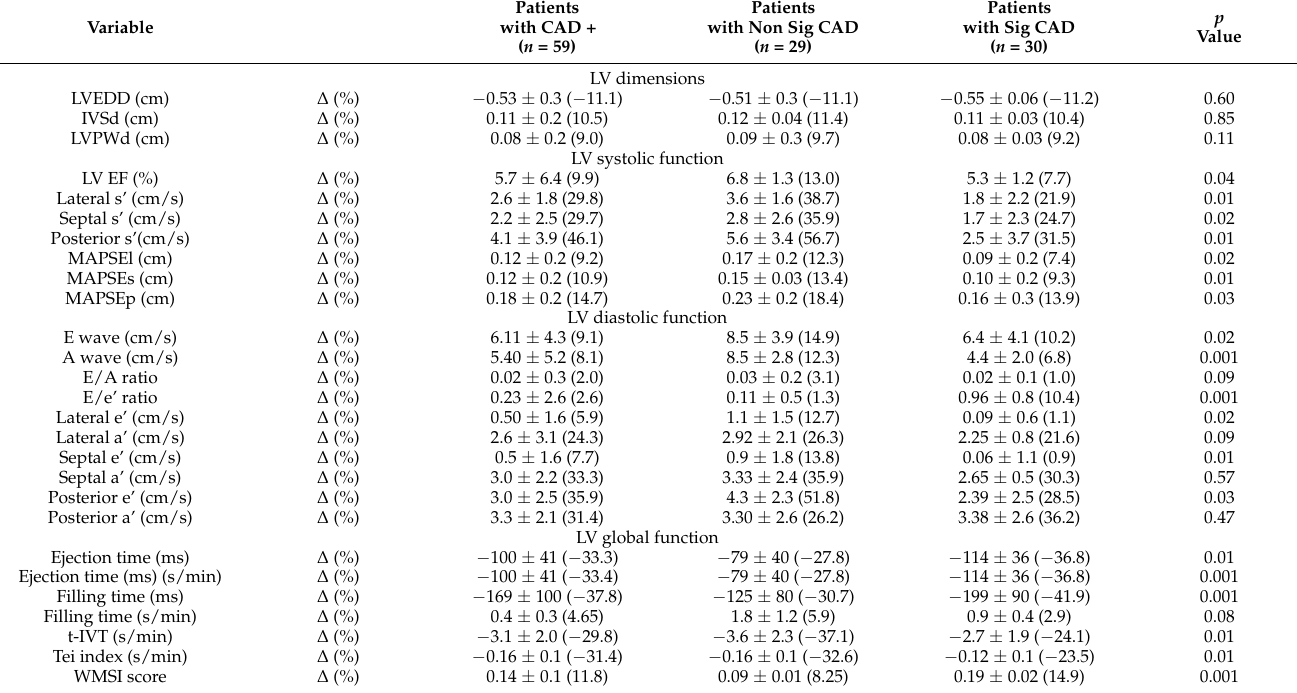
Table 2. Baseline and echocardiographic indices among nonsignificant and significant CAD.